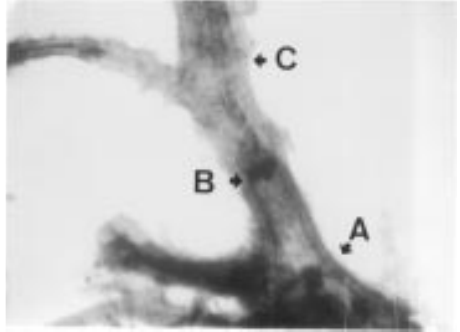
Figure 3 - Arciform artery from a norepinephrine-treated rat with a heterogeneously per- fused kidney. A , Well-perfused segment (presence of Prussian blue); B , segmental vasocon- striction; C , ischemic segment (distal portion of the